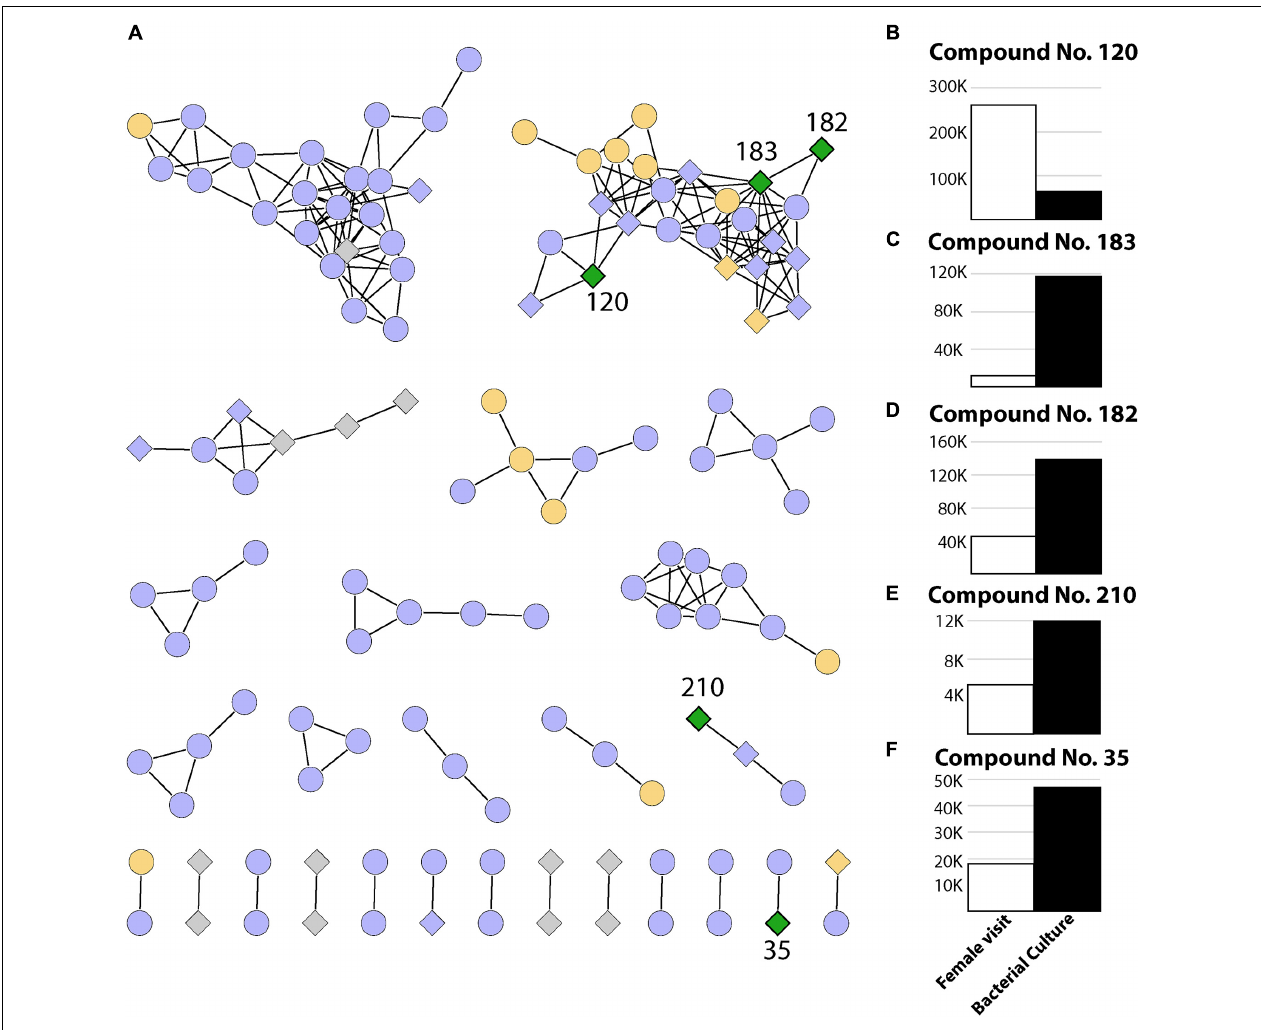
FIGURE 3 | Summary of 239 metabolites identified in this study. (A) Networks containing two or more metabolites (nodes) connected by edges when a minimum number of matching fragments is present (see section “Materials and Methods”). The coloring represents metabolites identified in experiments where only the female visited (T 2 , green), where the female visited and/or eggs were manually placed (T 2 and/or T 3 , orange), where metabolites were present in the control sample and/or T 3 and/or T 2 (purple), as well as metabolites detected only in bacterial cultures (gray). Diamonds represent bacterial metabolites, while circles represent metabolites not present in bacterial samples. (B–F) Relative abundance (area under the curve from mass spectrometry) for compounds present in breeding site experiments where the female visited (T 2 ) and also present in bacterial extracts (green